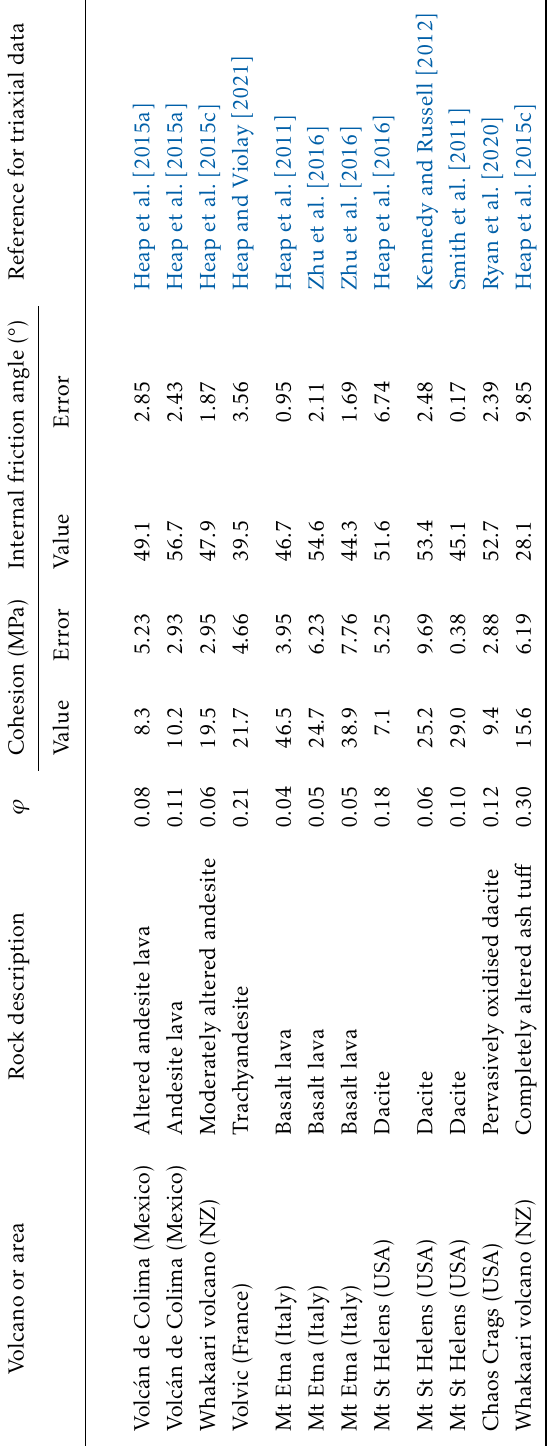
Table 1: Derived laboratory-scale cohesion and internal friction angle, with their propagated errors, for a range of volcanic rocks and textures (andesite, basalt, dacite, and tuff), calculated from a compilation of published tri- axial datasets, where ϕ is the average connected poros- ity. Each derived value is based on test results from 3– 5 individual samples in the source publications. Alter- ation and primary texture are given, if provided in the source